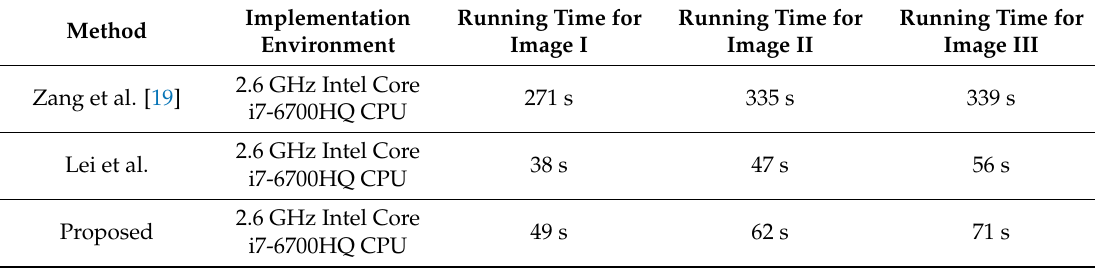
Table 5. Time consumption of the three